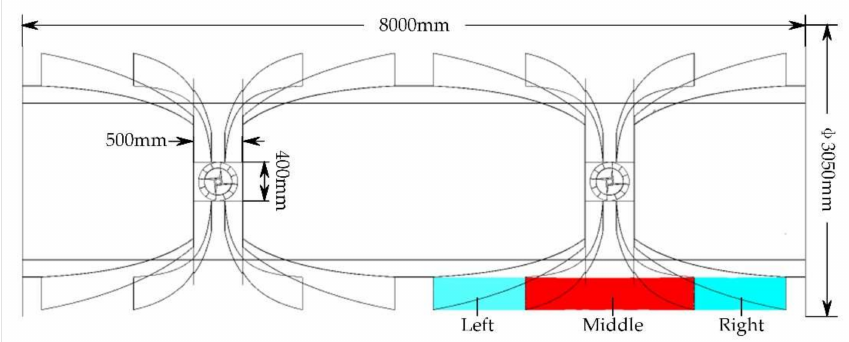
Figure 3. Schematic diagram of the mass flow monitoring faces of each guide channel.